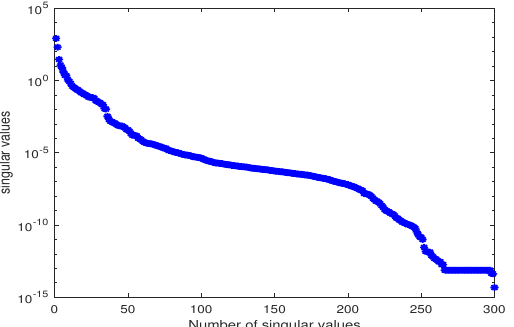
Figure 2. Singular values of snapshot matrix X for estimating parameter k s 1